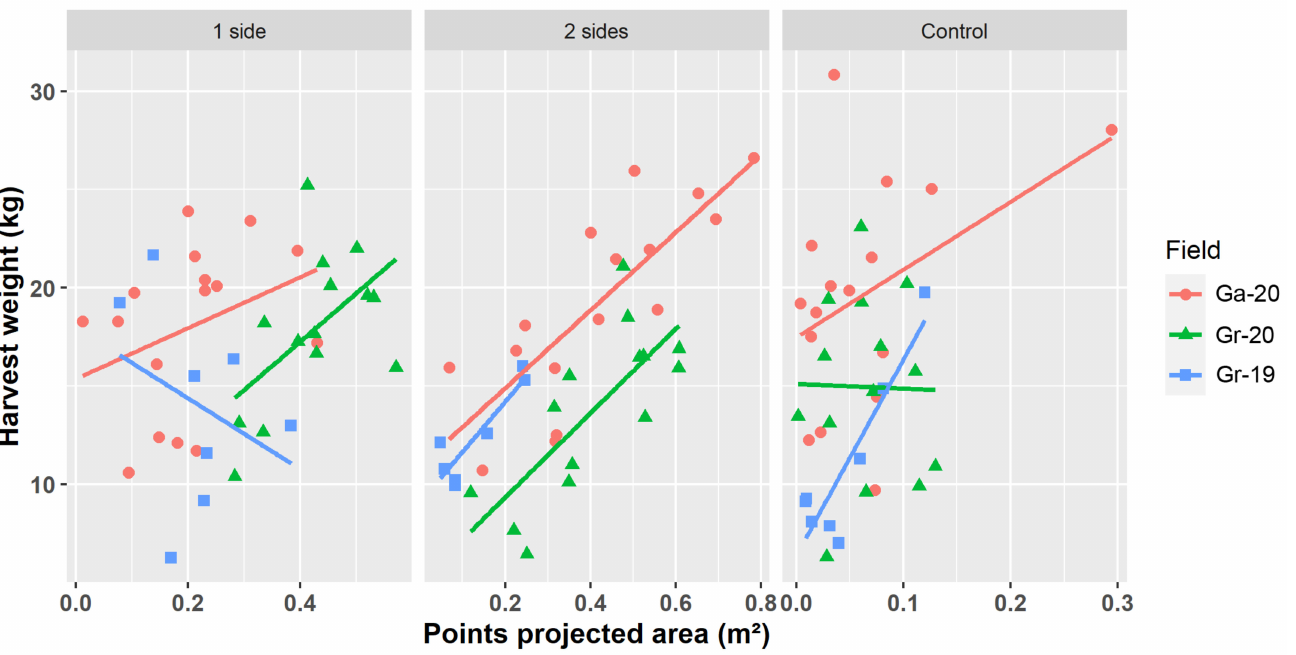
Figure 6. Scatter plots representing the relationship between the detected points projected area and the harvest weight for the different treatments and fields. Lines indicate the regression lines for each